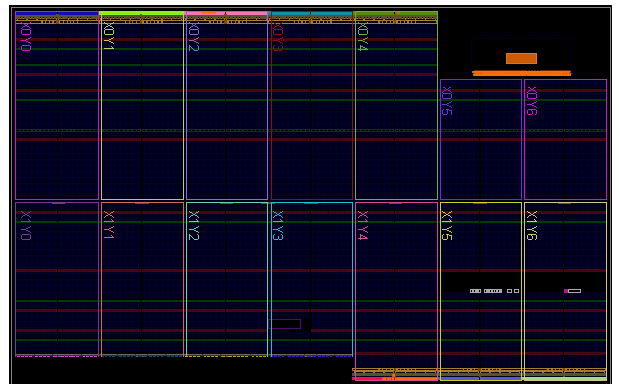
Figure 13. Gate-level Netlist generated in Vavido.